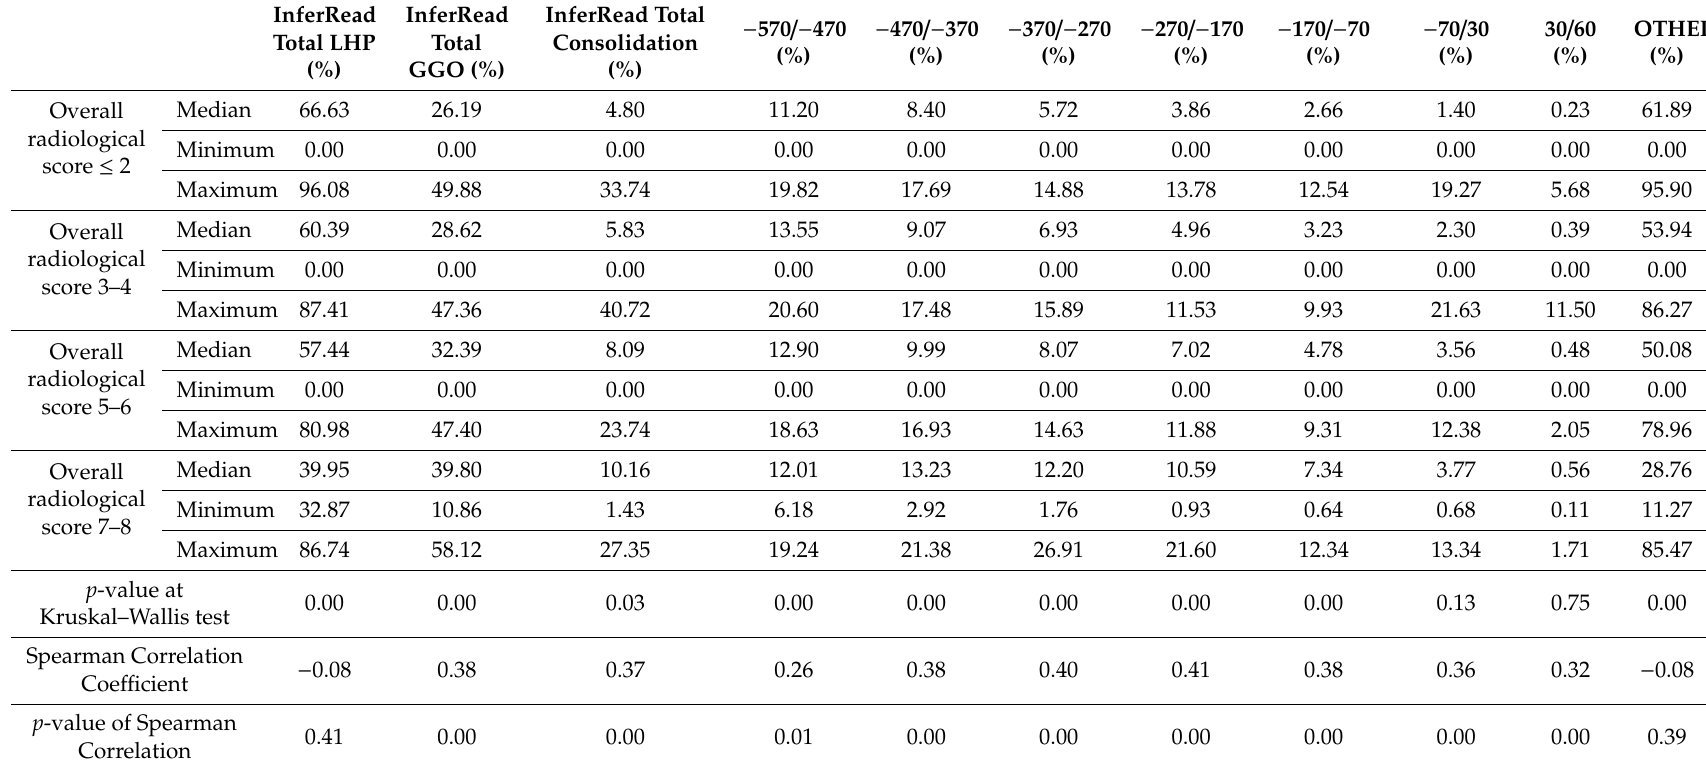
Table 6. InferRead quantitative results compared with radiological